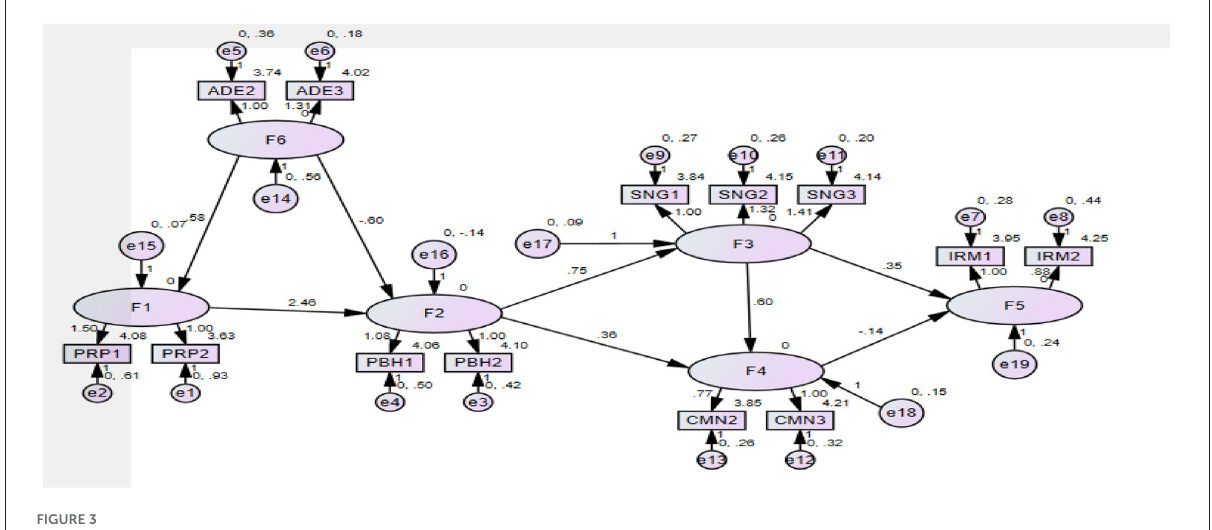
FIGURE3 Results of the path